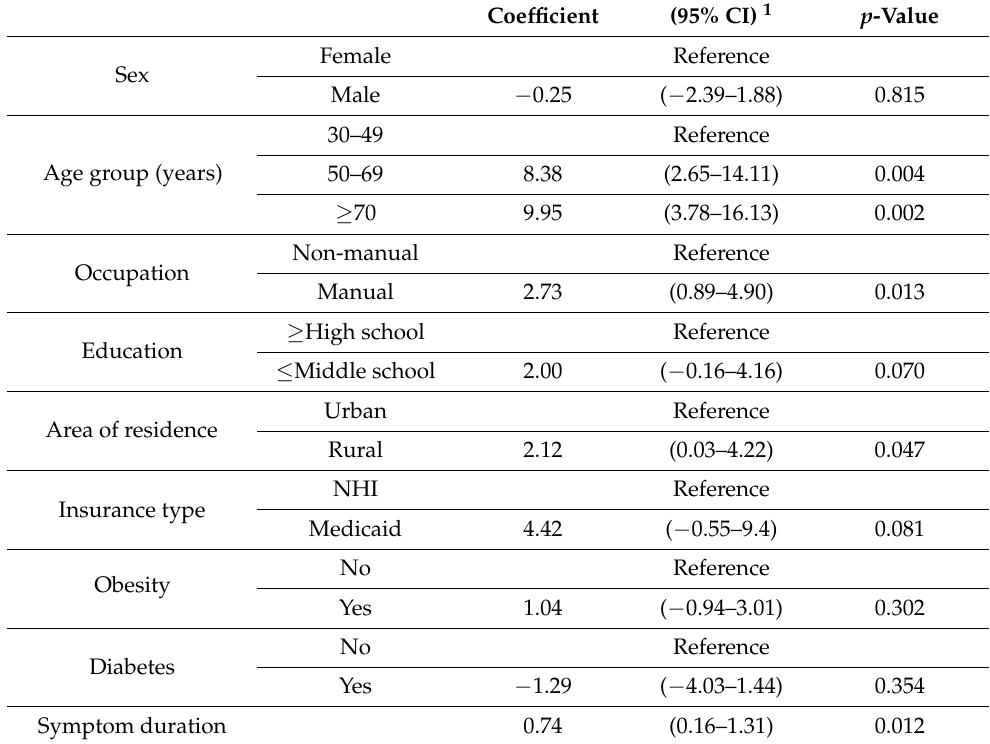
Table 3. Results of multivariate regression analysis on the influence of factors on the size of the non-traumatic full thickness rotator cuff